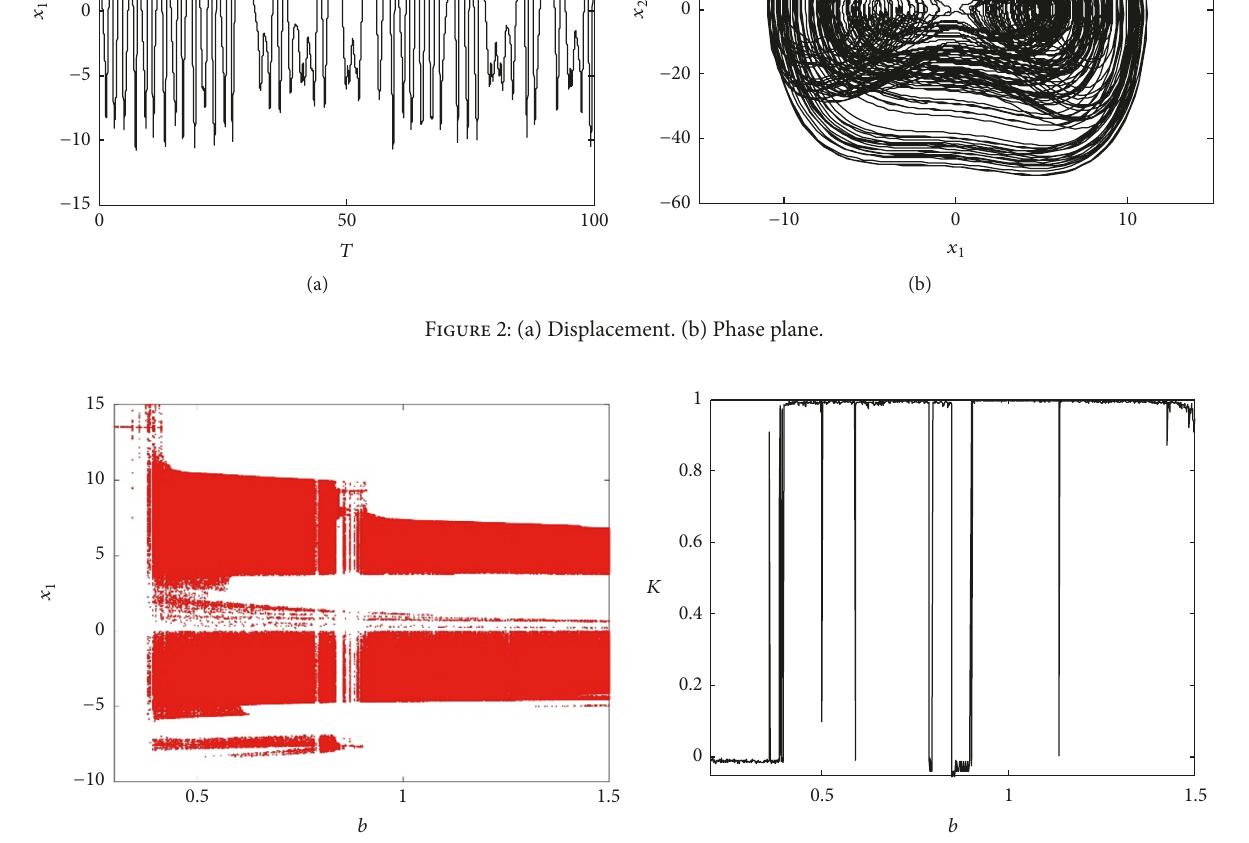
Figure 3: (a) Bifurcation diagram ( 𝑏 versus 𝑥 1 ). (b) 𝐾 versus 𝑏